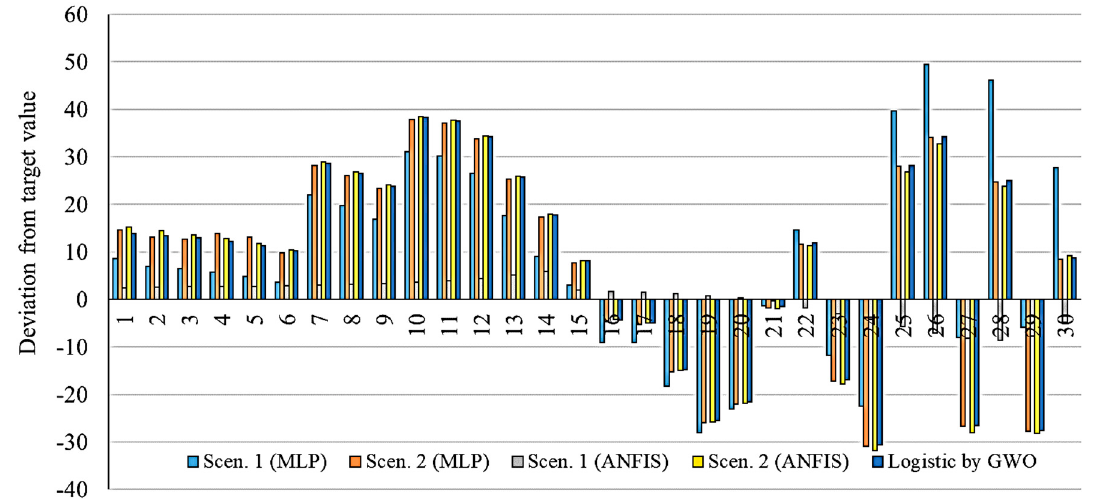
Figure 21. Deviation from target value for models related to USA.